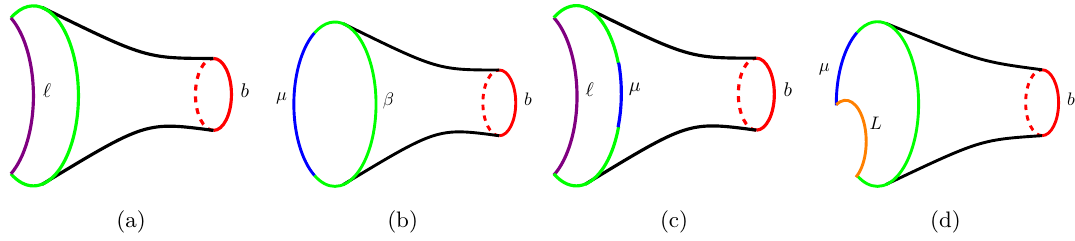
Figure 2 . Four different possible trumpet geometries corresponding to four distinct wavefunctions or partition functions. The closed geodesic boundary is depicted in red. In figure (a) we see the generalisation of the disk configuration, figure 1(a) to the trumpet. Figure (b) corresponds to the partition function on a trumpet geometry with both an EOW brane and an asymptotically AdS boundary. Figure (c) shows the wavefunction of a geodesic connecting two points on an asymptotically AdS boundary which contains an EOW brane. Lastly, in figure (d) we see a geodesic connecting EOW brane and AdS boundary on a trumpet